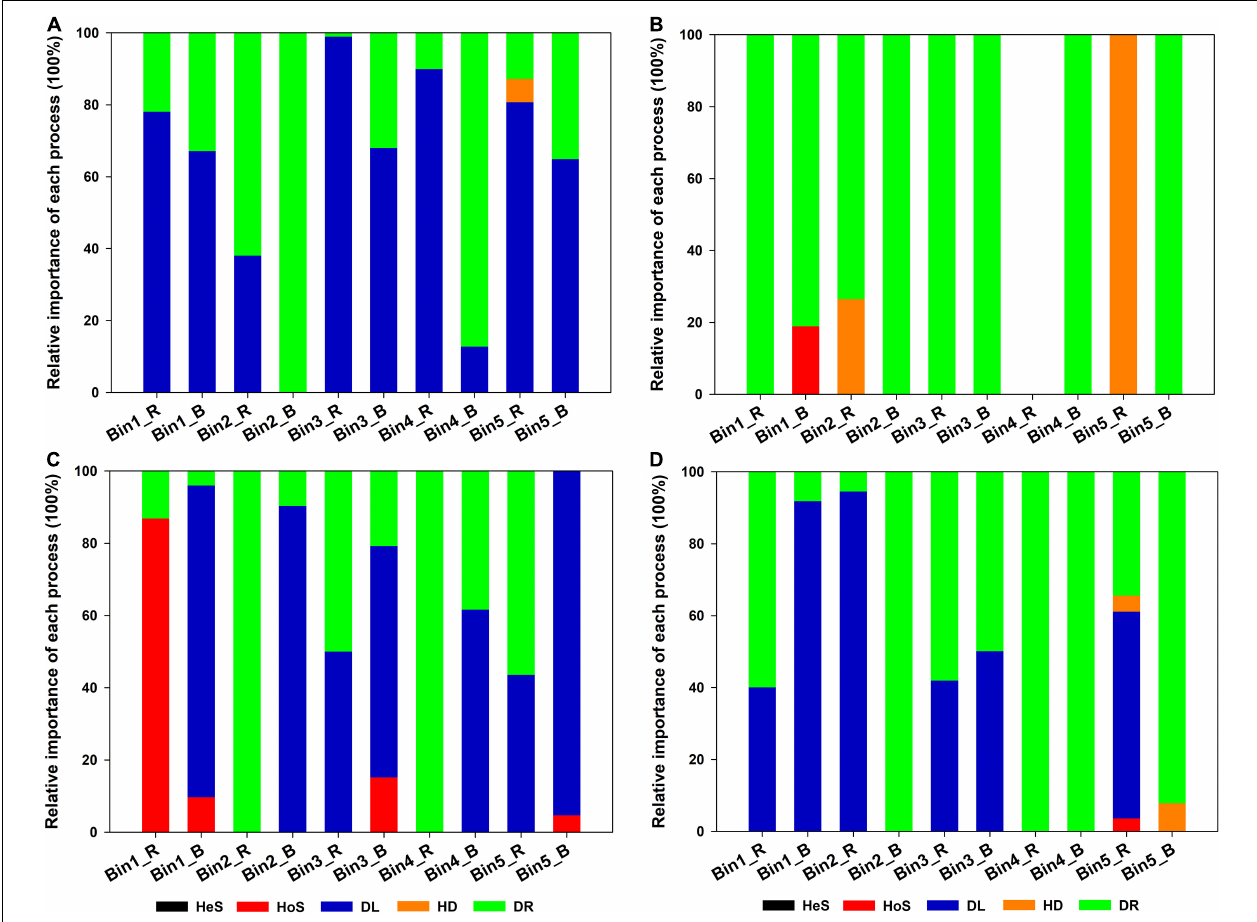
FIGURE 4 | Relative importance of each ecological process for each iCAMP microeukaryotic lineage bin across the four sampling sites: (A) Sheqi (SQ), (B) Tengzhou (TZ), (C) Daming (DM), and (D) Taihe (TH). Only the five most abundant bins are shown. Source data can be found in Supplementary Table 2 . For abbreviations, please see Figure 3